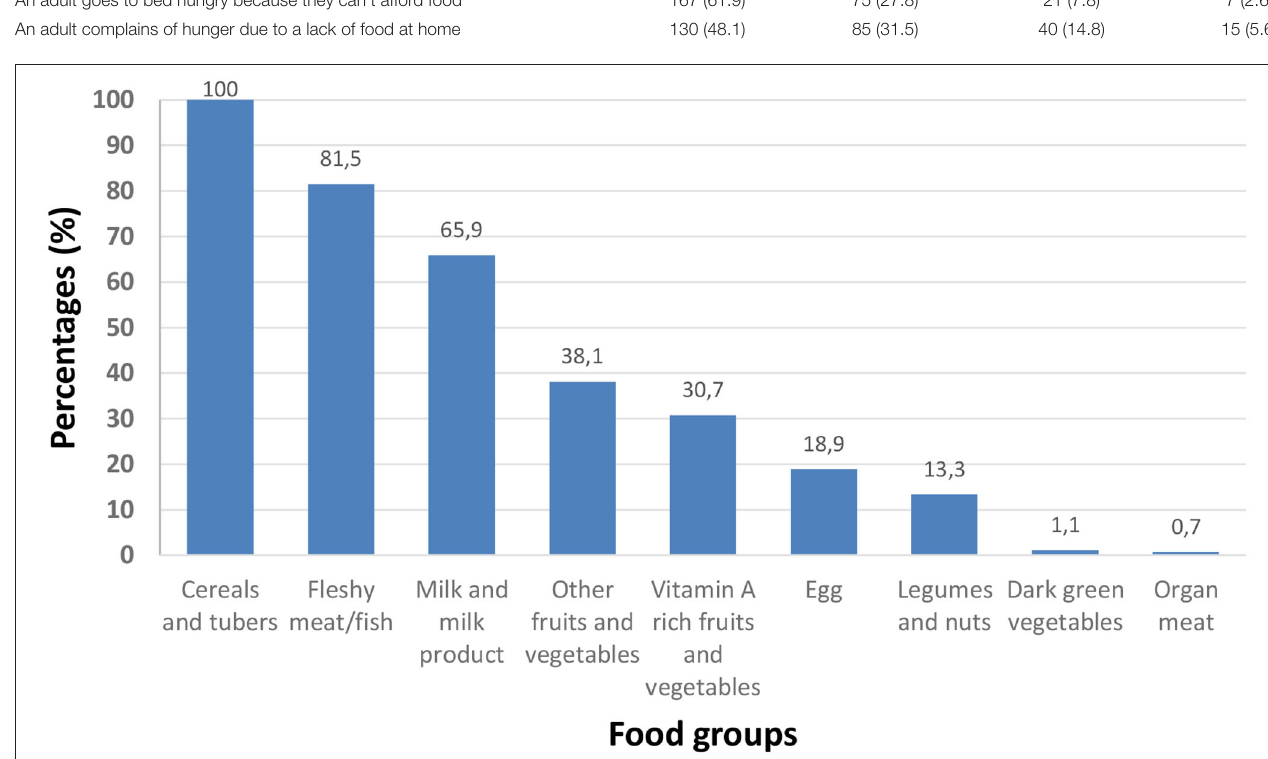
FIGURE 1 | The proportion of consumed foods groups in the past 24 h in sociology students of Caracas, 2016.